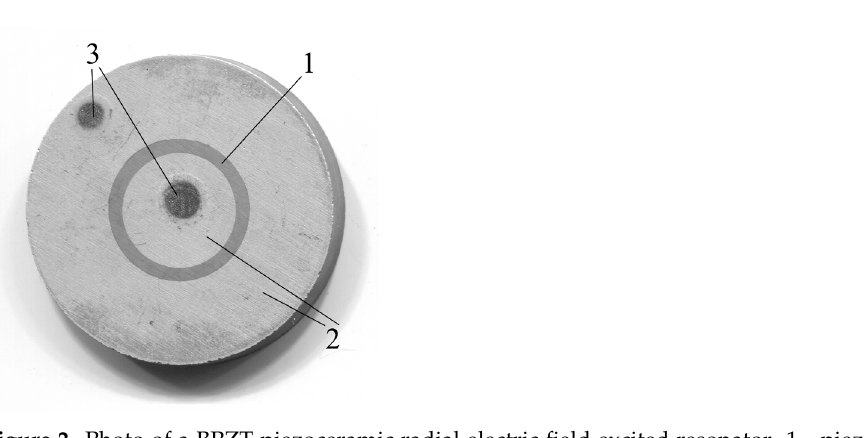
Figure 2. Photo of a BPZT piezoceramic radial electric field excited resonator. 1—piezoceramics, 2—aluminum electrodes, and 3—areas of soldering wires.